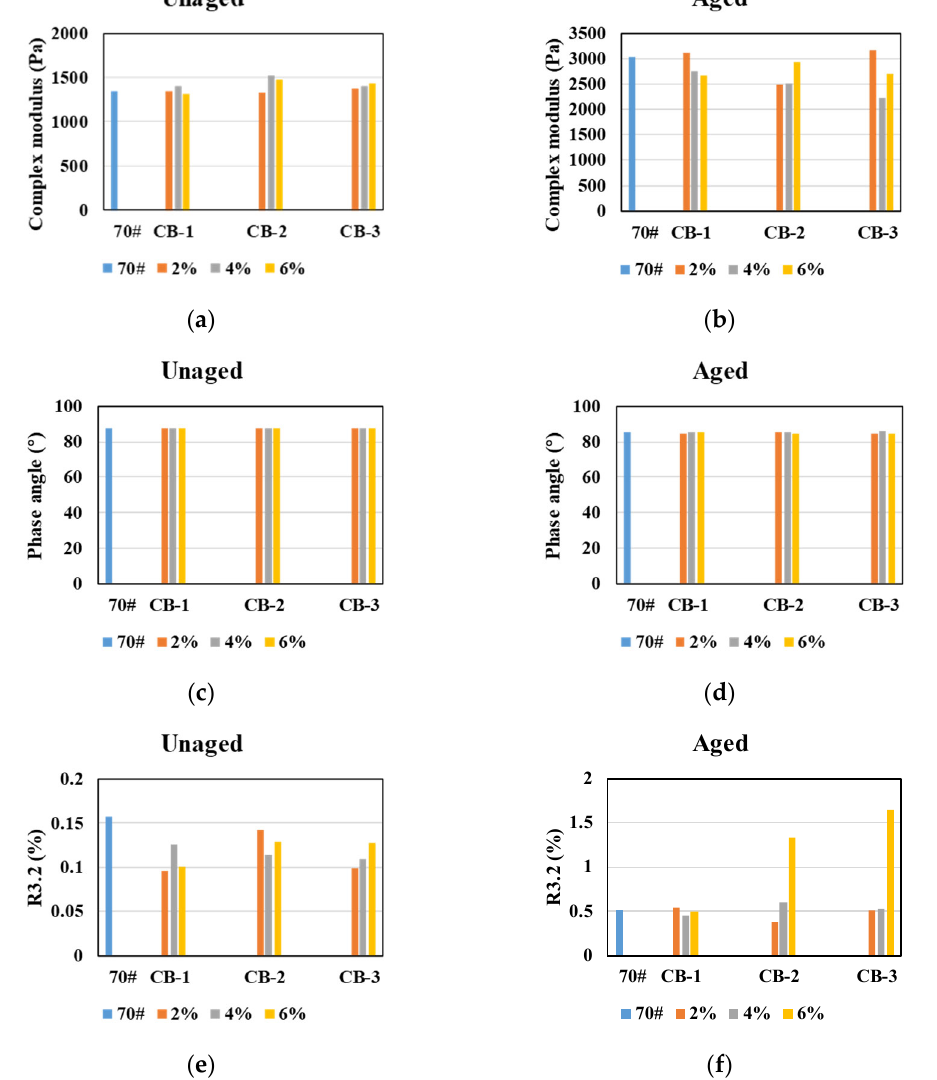
Figure 9. Comparison of unaged asphalt and asphalt after TFOT aging: ( a , c , e ) unaged asphalt; ( b , d , f ) asphalt after TFOT aging.